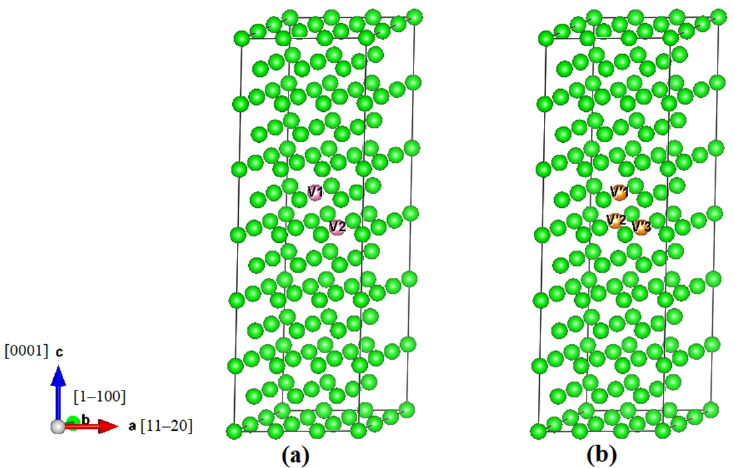
Figure 1. Supercells of pure α -Zr containing ( a ) 142-atom supercell with two different vacant lattice sites for one vacancy and one alloying element, ( b ) 141-atom supercell with three different vacant lattice sites for two vacancies and one alloying element.